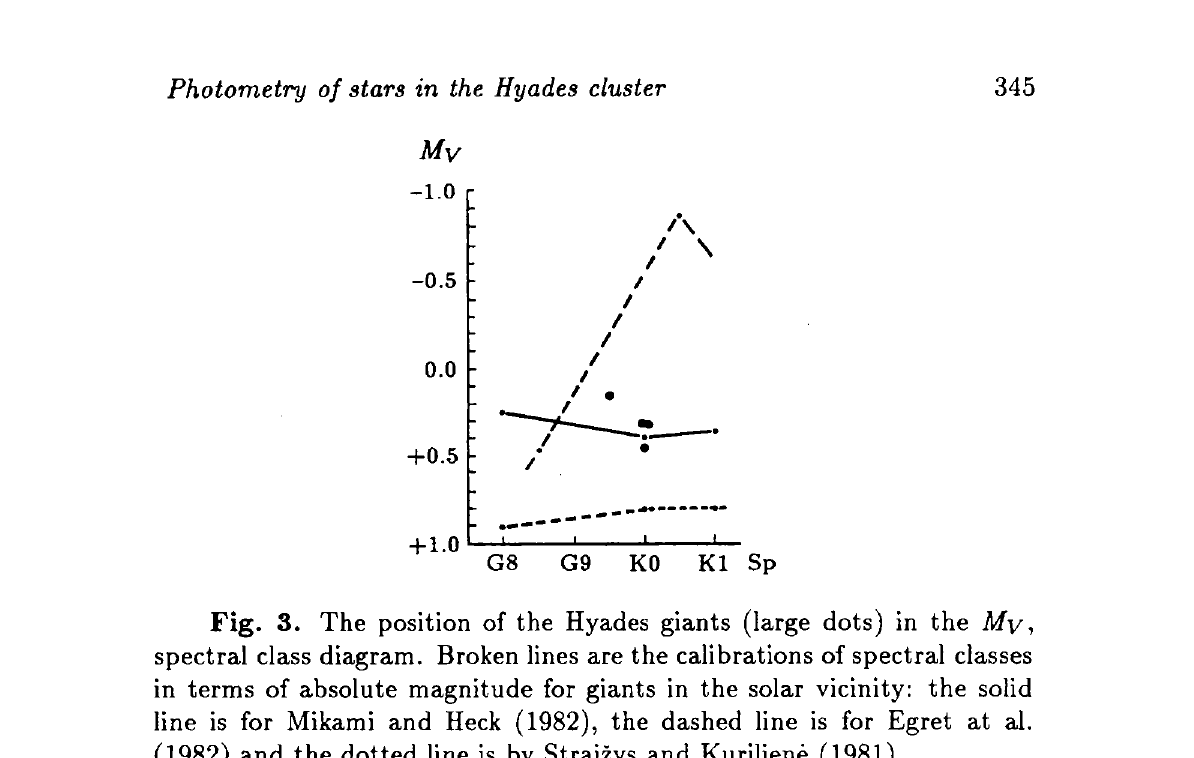
Fig. 3. The position of the Hyades giants (large dots) in the My, spectral class diagram. Broken lines are the calibrations of spectral classes in terms of absolute magnitude for giants in the solar vicinity: the solid line is for Mikami and Heck (1982), the dashed line is for Egret at al. (1982) and the dotted line is by Straizys and Kuriliené